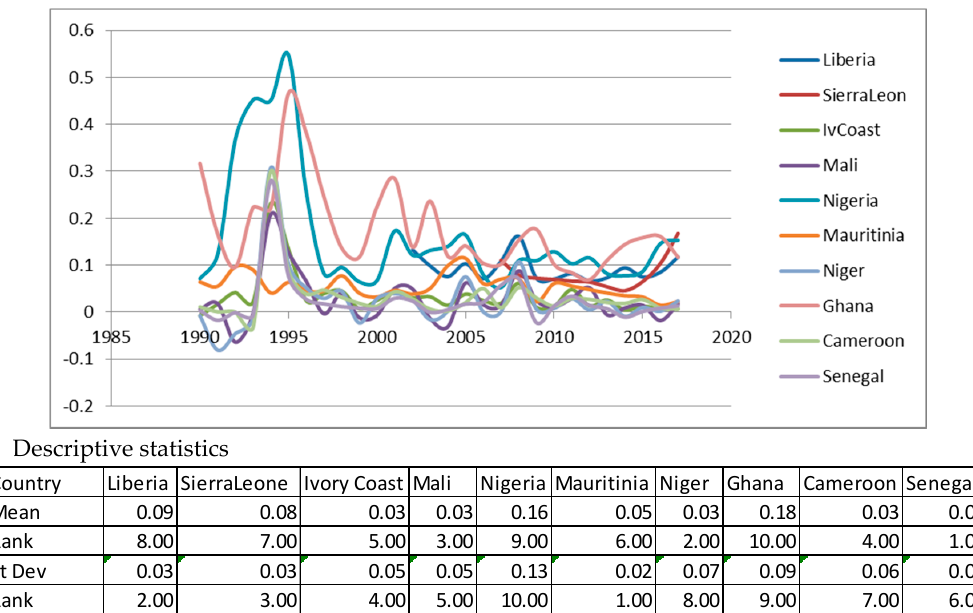
Figure A2. Inflation based on Consumer Price Index CPI in the ten countries (1990–2017).